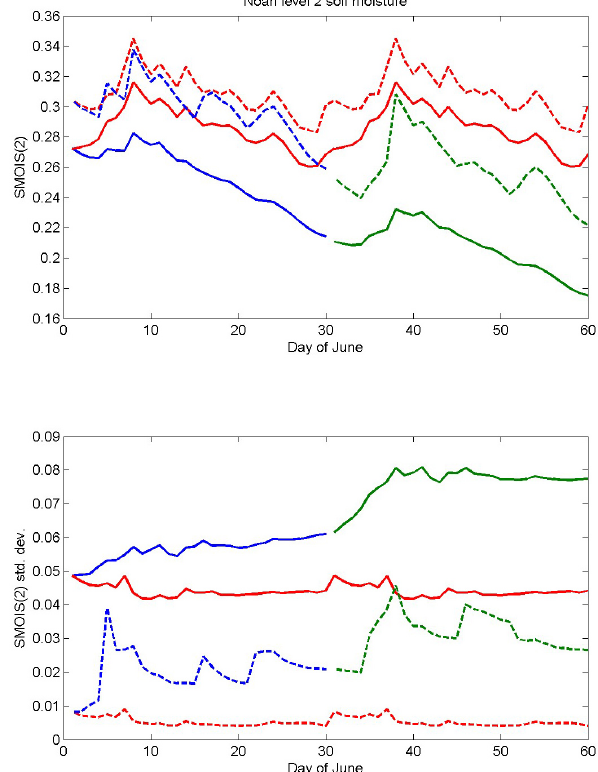
Figure 4. Soil moisture mean (top) and spatial standard deviation (bottom) during June 2011. Each day of June appears twice on the horizontal axis to show the evolution through two cycles. Color scheme: red is ERA-Interim, blue Noah cycle 1, and green Noah cycle 2. Solid lines are averages over whole inner domain; dashed lines are averages over 10 × 10 grid points extending northeast from the experiment